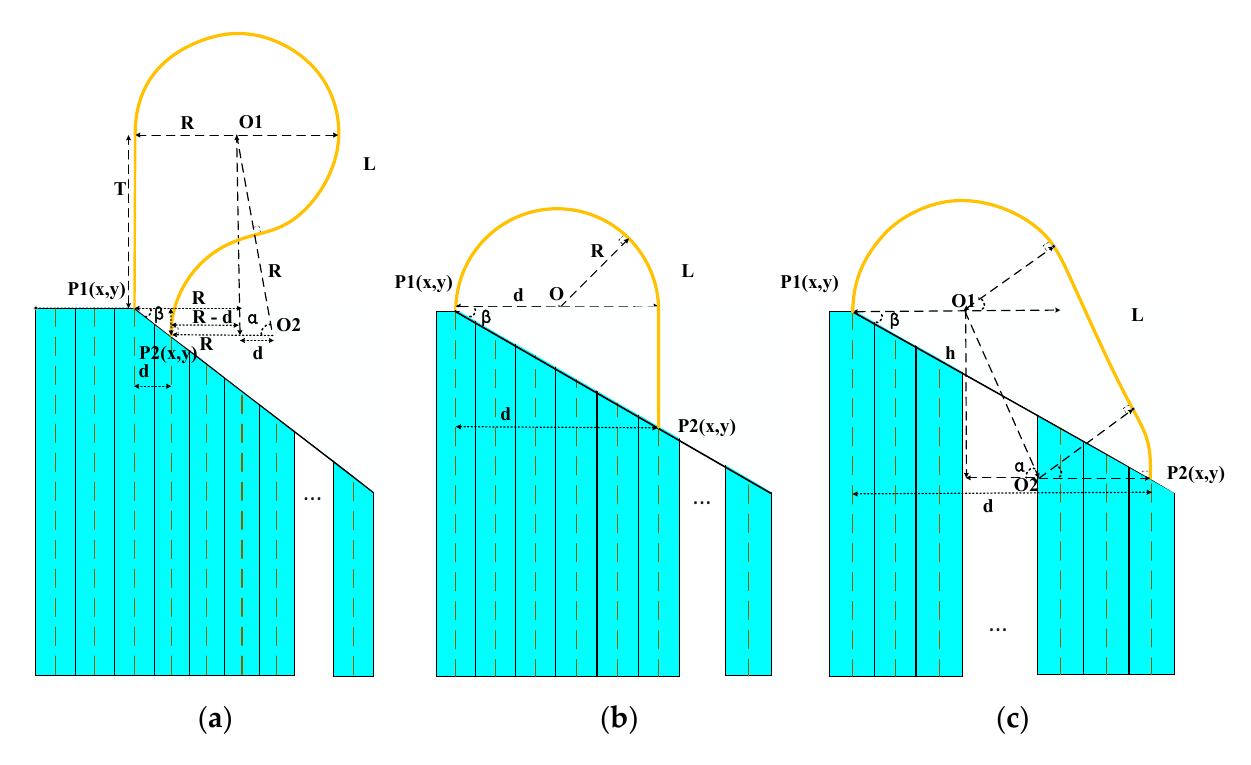
Figure 3. Different scenarios of turning: ( a ) span less than turning radius, ( b ) span equal to turning radius, and ( c ) span greater than turning radius.